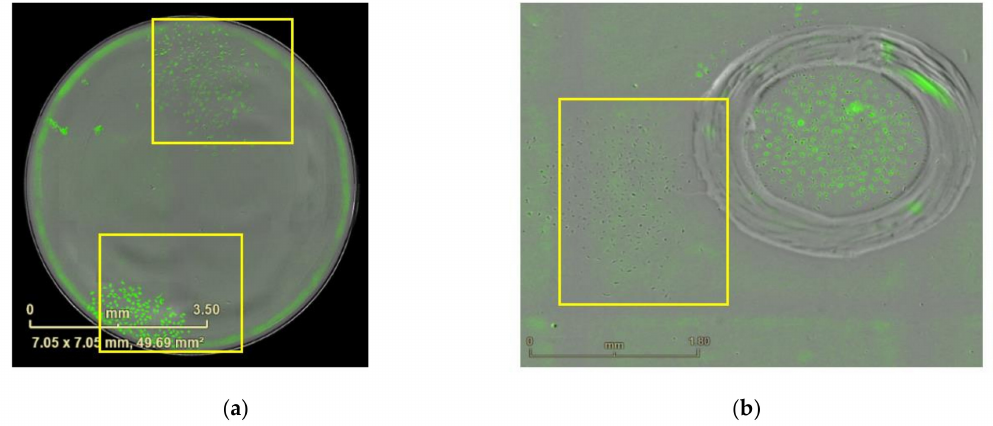
Figure 11. Imaging of the polyclonal cells before elimination. ( a ) Polyclone from 96-well plate. Scale bars = 3.5 mm. The yel- low squares show monoclonal cells separated with each other. ( b ) Polyclone from 6-well plate. Scale bars represent 1.8